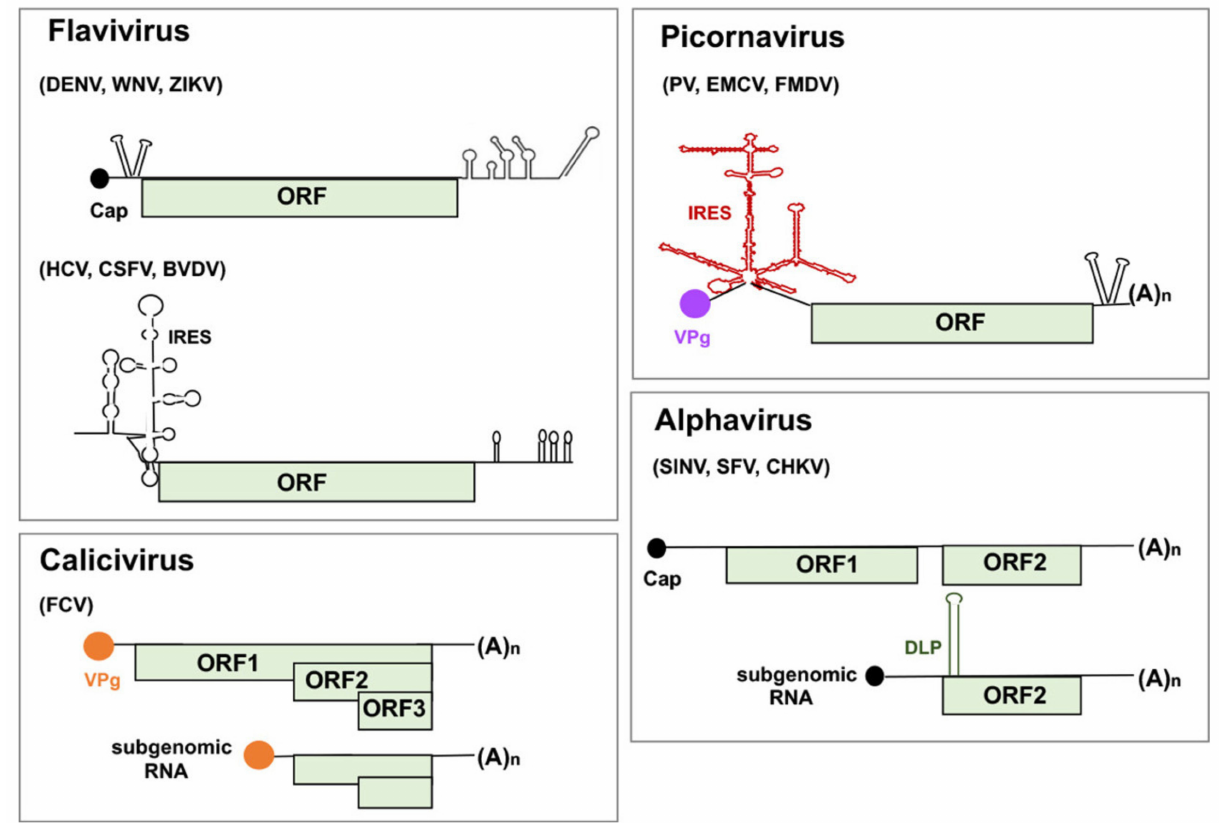
Figure 1. Diagram of the genomic RNA of flavivirus, picornavirus, alphavirus, and calicivirus. The regulatory elements targeted by host RNA-binding proteins (RBPs) described in this review are depicted. The RNA length of the genome is approximately drawn to scale (flavivirus 10–11 kb, picornavirus 7.5–9 kb, alphavirus 12 kb, calicivirus 7.4–8.3 kb). In all cases the open reading frame (ORF) encodes a polyprotein, which is processed into the mature viral proteins. Stem-loops on the 5 (cid:48) and 3 (cid:48) UTRs of the viral RNA, as well as the downstream stem-loop (DLP) of alphavirus, are schematically represented by hairpins. A black circle depicts the m 7 GTP residue at the 5 (cid:48) end of the mRNA in flavivirus (Dengue virus (DENV), West Nile virus (WNV), Zika Virus (ZIKV)) and alphavirus (Sindbis virus (SINV), Semliki forest virus (SFV), Chikungunya (CHKV)); the violet and orange circles depict the viral protein (VPg) covalently linked to the 5 (cid:48) end in picornavirus (Poliovirus (PV), encephalomyocarditis virus (EMCV), foot-and-mouth disease virus (FMDV)) and calicivirus (FCV) RNA, respectively, while (A)n denotes the poly(A) tail at the 3 (cid:48) end of the RNA in picornavirus, alphavirus, and calicivirus. The internal ribosome entry site (IRES) element present in a subset of flaviviruses (hepatitis C virus (HCV), classical swine fever virus (CSFV), bovine viral diarrhea virus (BVDV)) is depicted by black line. A red line depicts the IRES element of